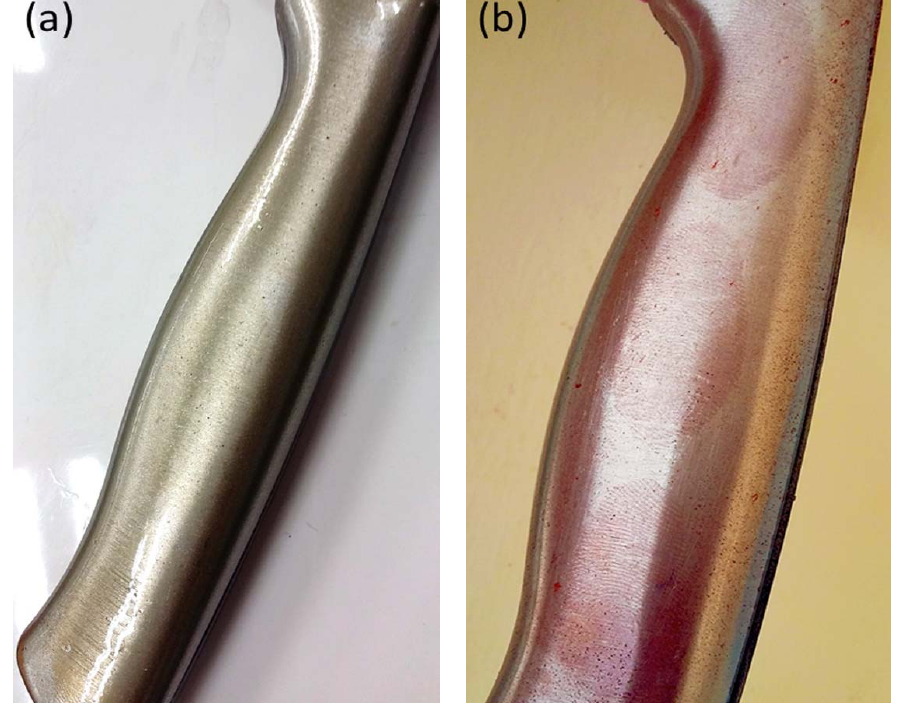
Figure 2. Representative photographs of fingerprints on a knife immersed in a natural outdoor pond (for five days) before ( a ) and after ( b ) the treatment with the safranin ‐ tinted CRL nanoconjugates reagent.